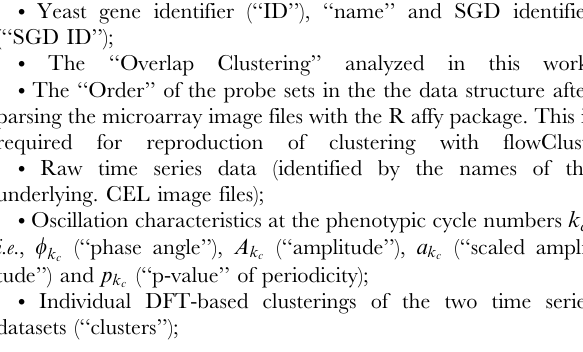
Dataset S5 Protein Binding Analysis: tuliCoarse.ChI- P.results.csv. A list of all 135 protein binding sites in